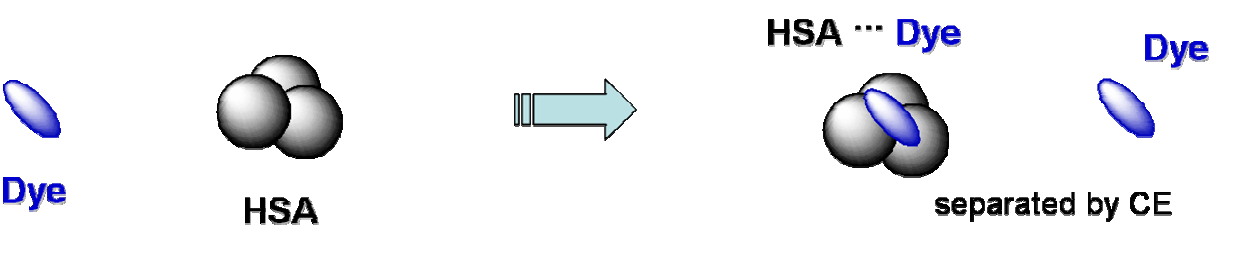
Figure 1. Illustration of noncovalent labeling of HSA with a